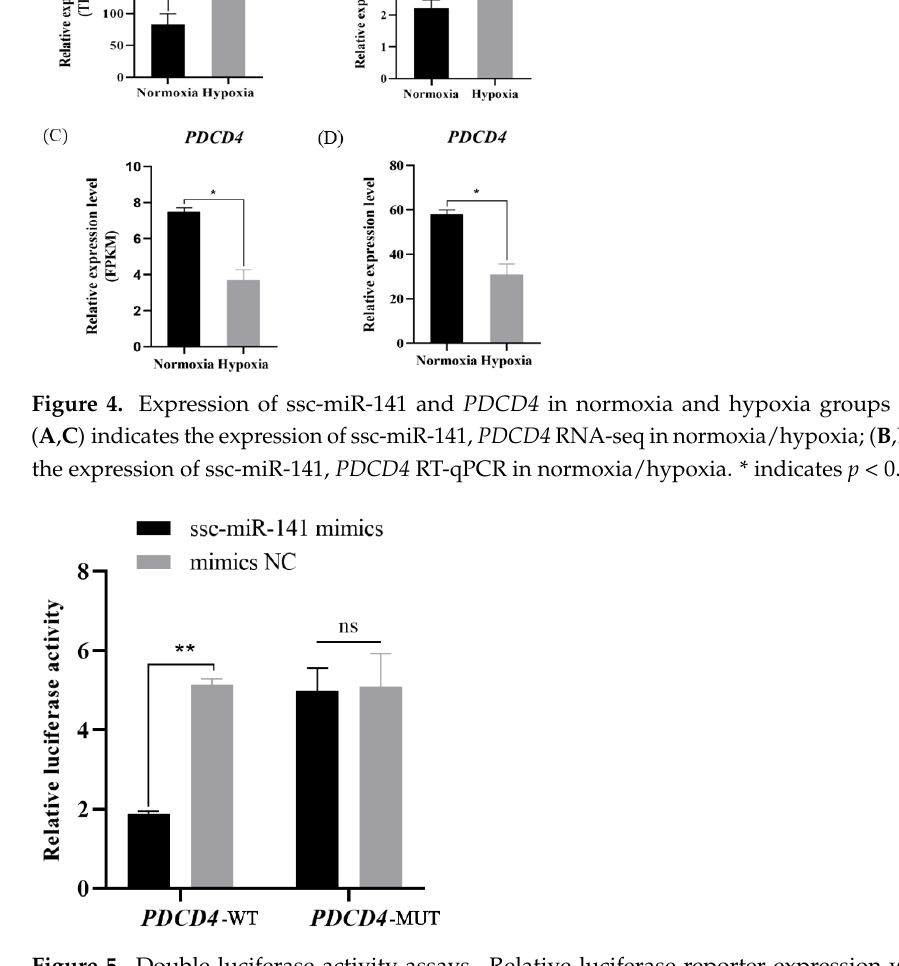
Figure 4. Expression of ssc-miR-141 and PDCD4 in normoxia and hypoxia groups (ATII cells). (A)(C) indicates the expression of ssc-miR-141, PDCD4 RNA-seq in normoxia/hypoxia; (B)(D) indi- cates the expression of ssc-miR-141, PDCD4 RT-qPCR in normoxia/hypoxia. * indicates p < 0.05.